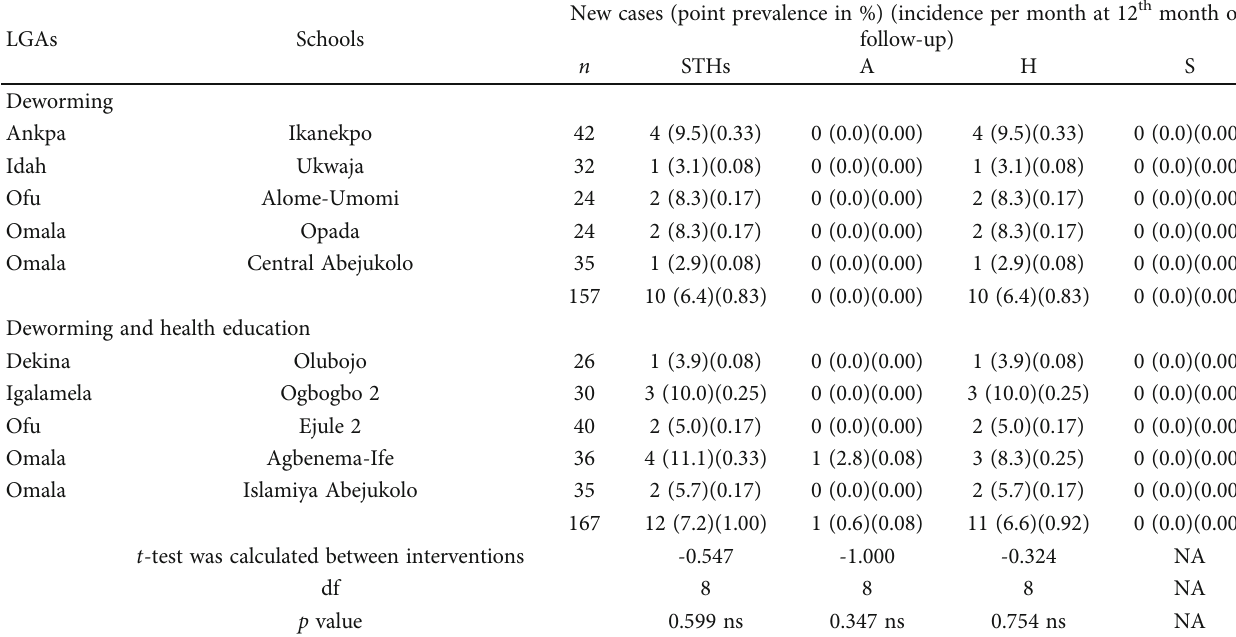
Table 6: Comparison of incidence of STHs at 48 th week for both interventions according to parasite